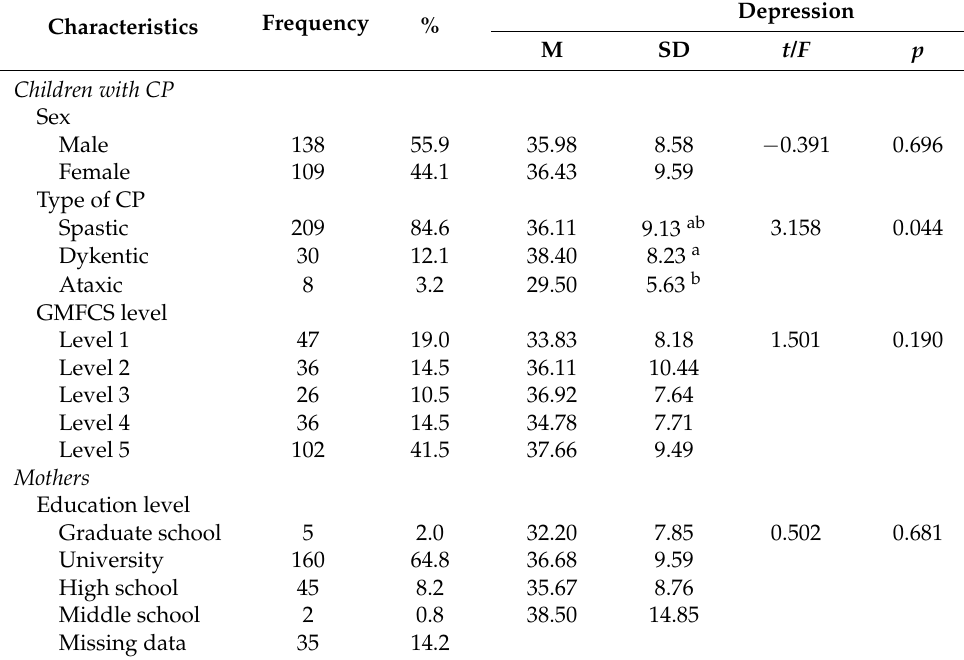
Table 1. Participants’ characteristics (children with CP and their